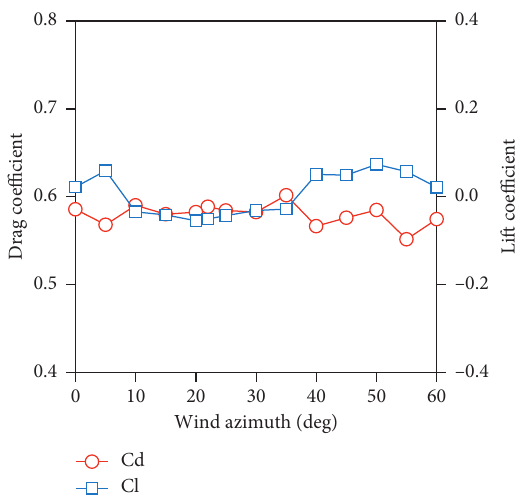
Figure 9: Drag and lift coefficients of the observatory.